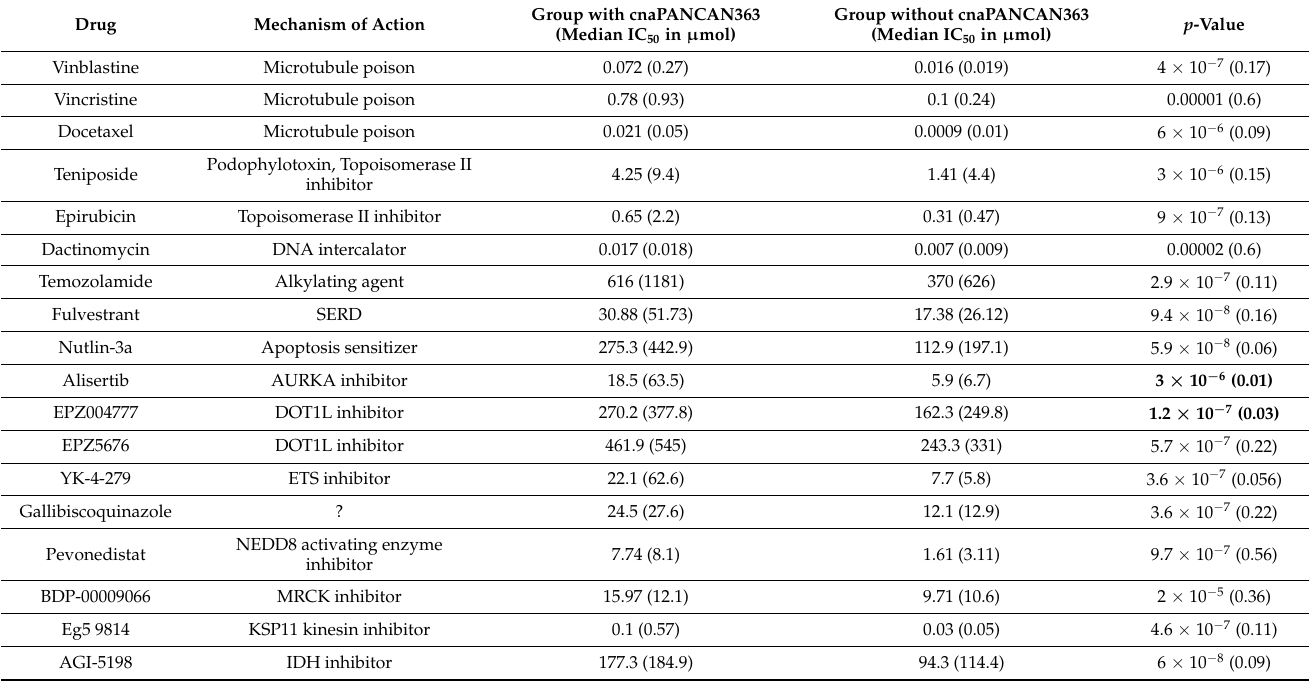
Table 3. Drug resistance associated with amplifications of 20q11.21 (feature cnaPANCAN363) in the whole CCLE cohort of cell lines, independently of primary type. In parentheses are respective values for the colorectal cancer cell lines cohort. Bold denotes significant in both the pan-cancer and the colorectal cancer cohort. IC 50 : Inhibitory Concentration 50%.